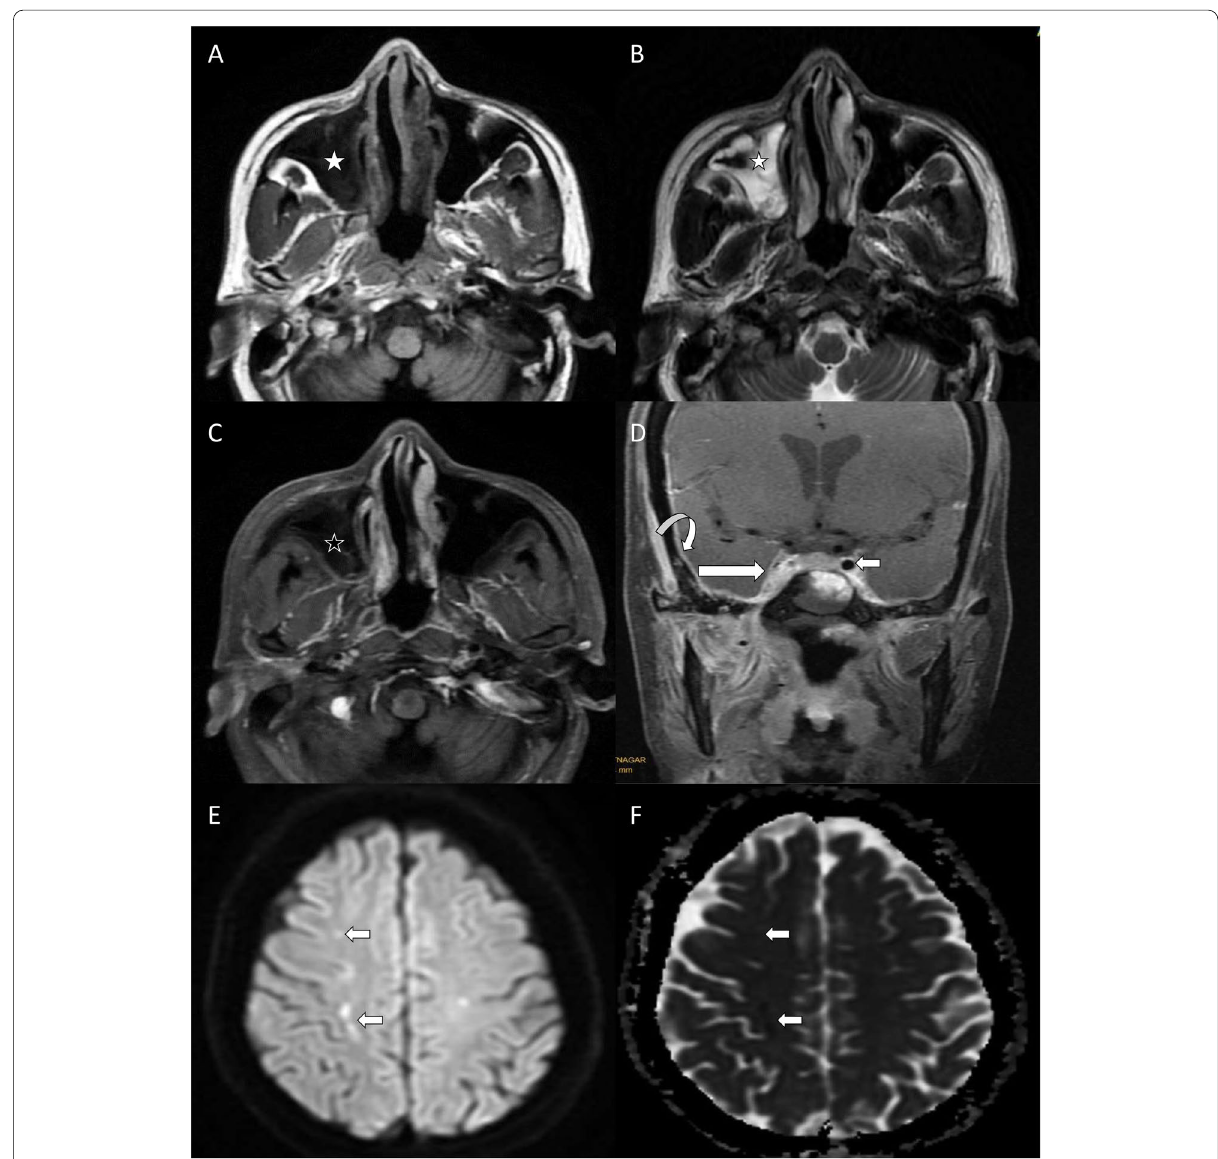
Fig. 2 Extension of sinonasal disease into the cavernous sinus. Axial T1- and T2-weighted images ( A and B ) show thickening of the right maxillary sinus wall (white stars) which shows no enhancement (black star) on axial contrast-enhanced fat-saturated T1-weighted image ( C ). Coronal contrast-enhanced fat-saturated T1-weighted image ( D ) shows non-enhancing areas within the right cavernous sinus with convex outward margin (straight long arrow), suggestive of cavernous sinus thrombosis. The flow void of the cavernous part of the right internal carotid artery is not seen (straight white arrow shows normal flow void of the internal carotid artery on the left side). The meninges appear thickened and show enhancement (curved arrow) indicating meningitis. Axial diffusion-weighted ( E ) and apparent diffusion coefficient ( F ) images show foci of restricted diffusion (straight short arrows) in the right centrum semiovale in the watershed territory, suggesting cerebral